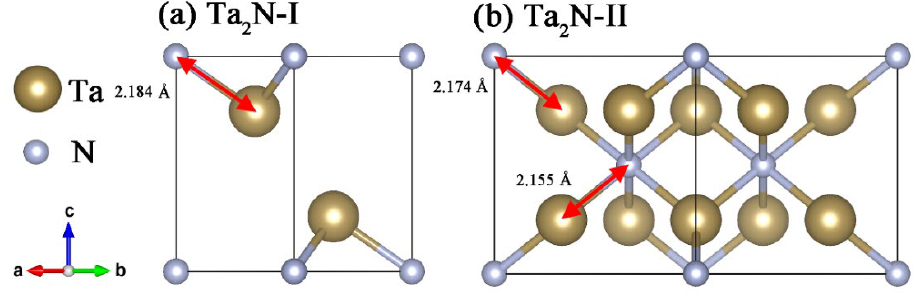
Figure 3. Comparison of the bond length (Å) variation of ( a ) Ta 2 N-I and ( b ) Ta 2 N-II.